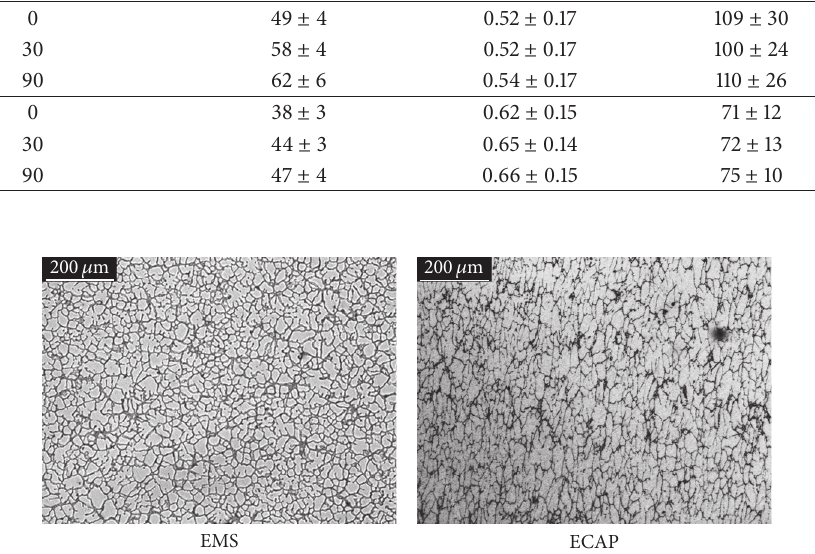
Figure 3: Conventional B&W metallography of the as cast Al-4.0wt%Si-2.5wt%Cu produced by EMS and after one ECAP pass.